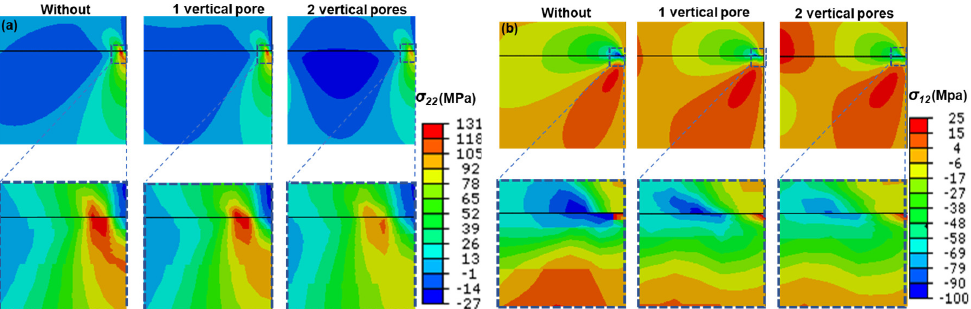
Figure 8. Variation of stress field: ( a ) σ 22 and ( b ) σ 12 at crack tip for 1 mm thickness of TC without, with one vertical pore, and with two vertical pores. The depth of vertical pores was 0.9 mm.